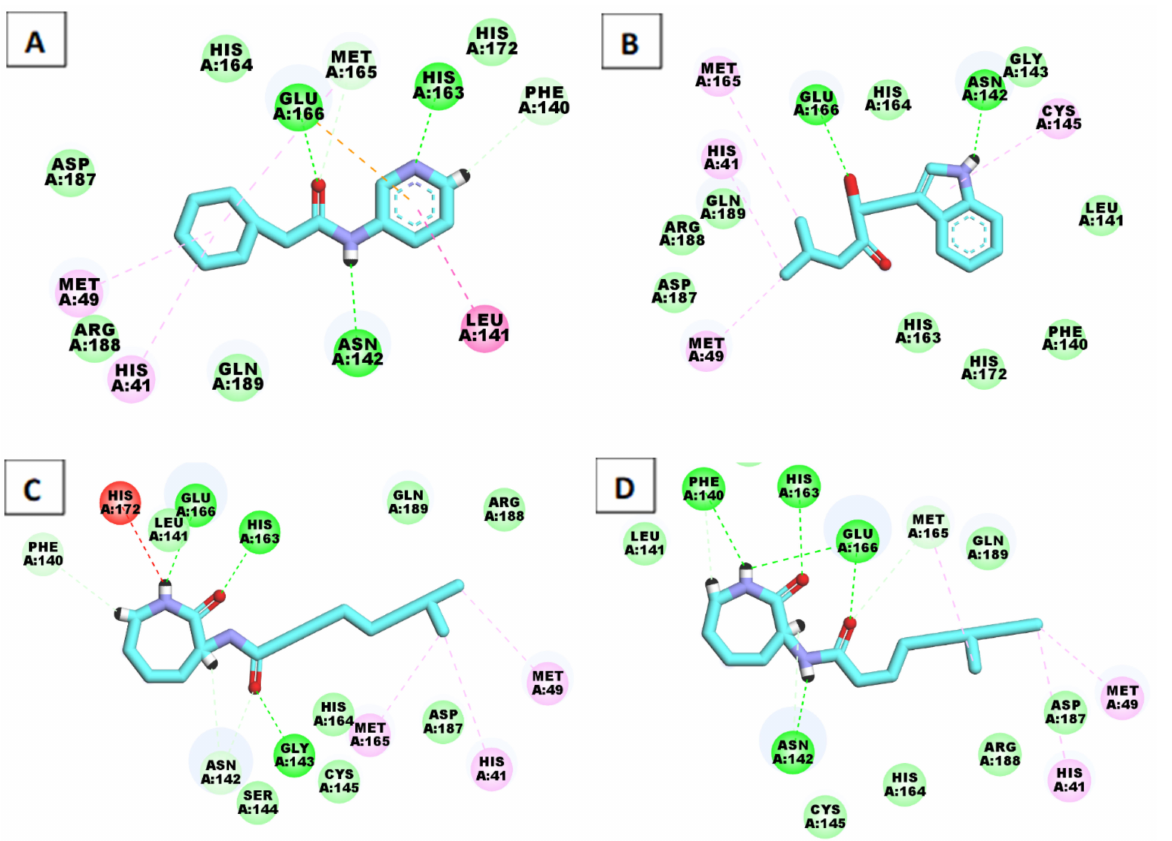
Figure 3. ( A ) 2D interaction of the tested compounds in the active site of M pro ; ( A ) GWS , ( B ) com- pound 291 , ( C ) compound 292 , ( D ) compound 293